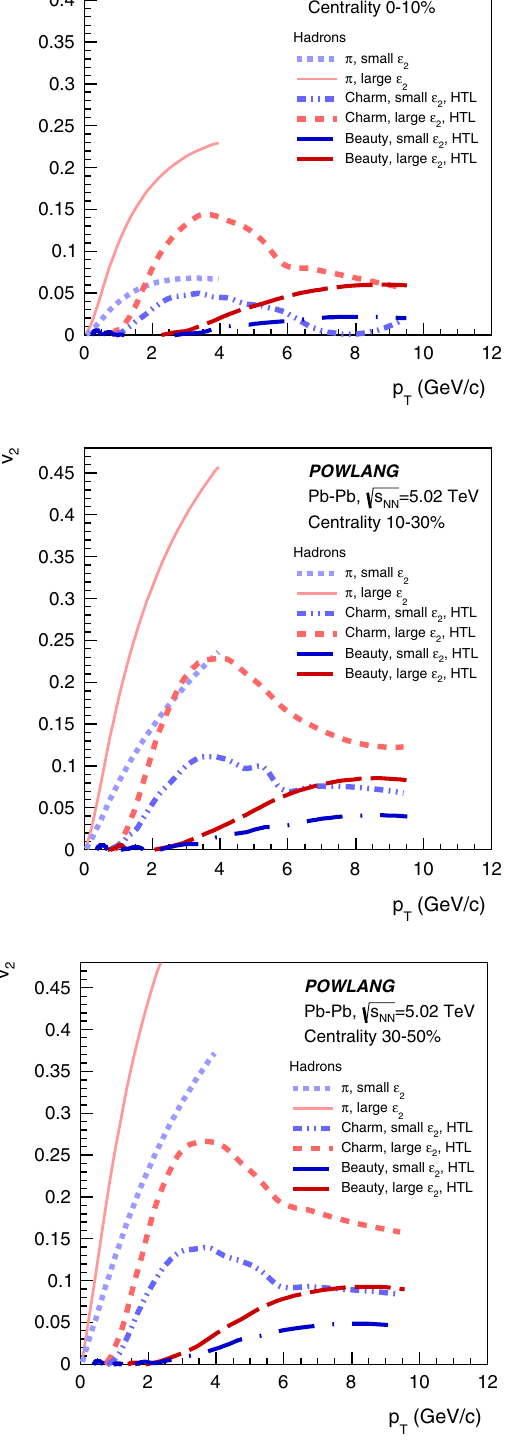
√ s NN = 5 . 02 TeV. Deviations from the unbiased case lisions at